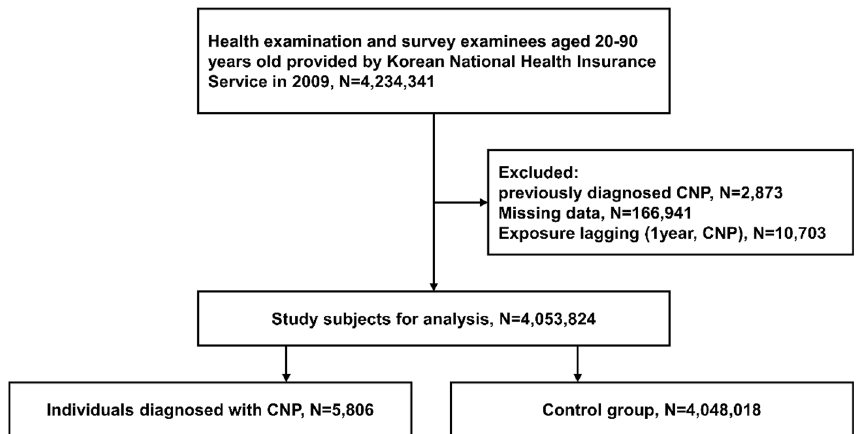
Figure 1. Flowchart of the enrollment process of the current study cohort. N numbers, CNP ocular motor cranial nerve